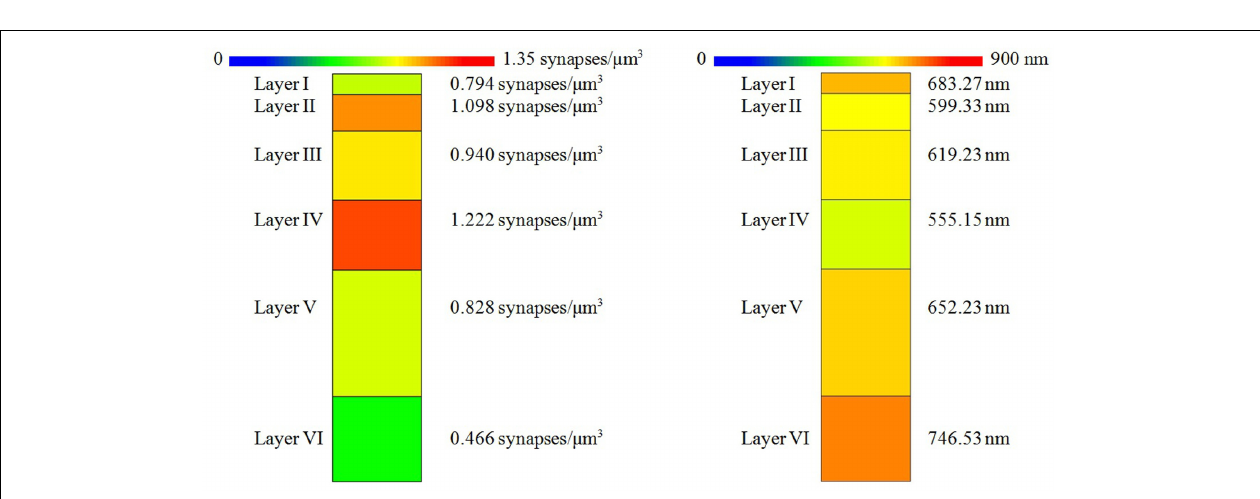
Mean distance to nearest synapse for each layer. Nearest synapse distances are significantly different in the six layers of the somatosensory cortex, but we found no significant differences between distances of layers I vs. V, I vs. VI, II vs. III, and III vs.